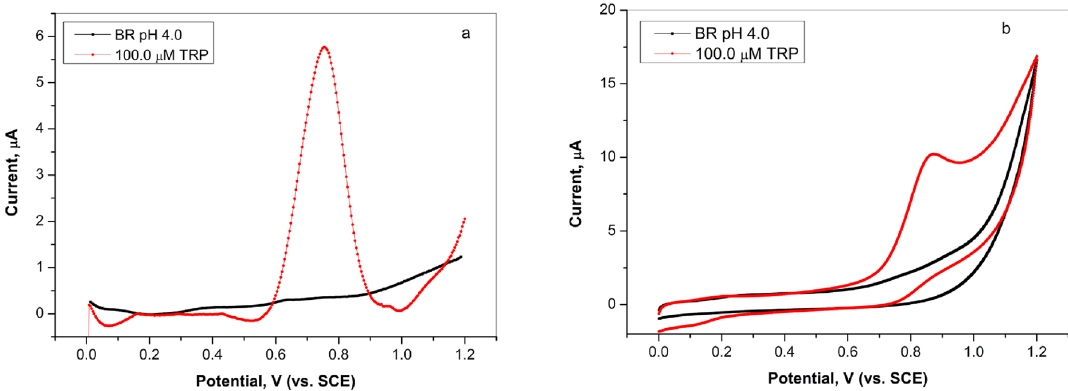
Figure 1. ( a ) Differential pulse voltammetry (curves subjected to baseline correction) and ( b ) cyclic voltammetry curves on graphite electrode in Britton–Robinson buffer solution (pH 4.0) in the absence and in the presence of 100.0 µM of L-tryptophan, scan rate 50.0